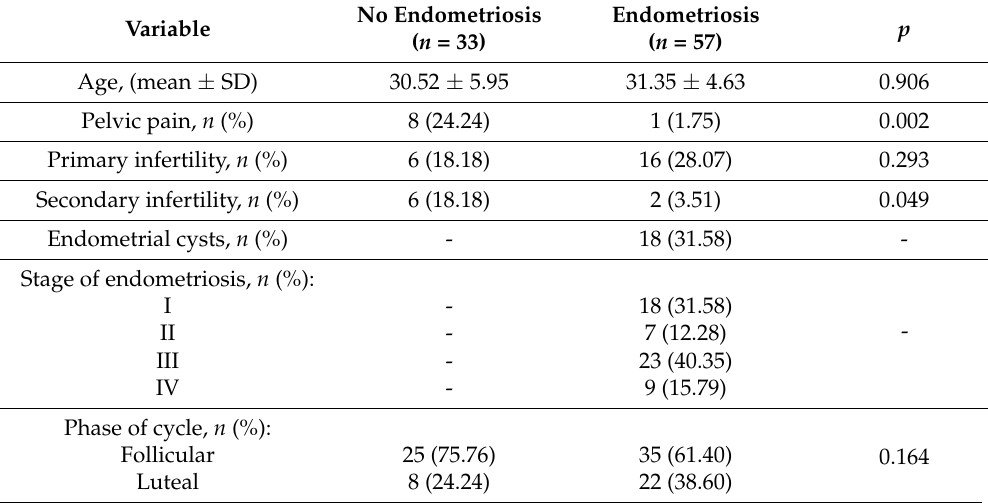
Table 1. Characteristics of the study (endometriosis) and control group (no endometriosis). No Endometriosis Variable ( n = 33)